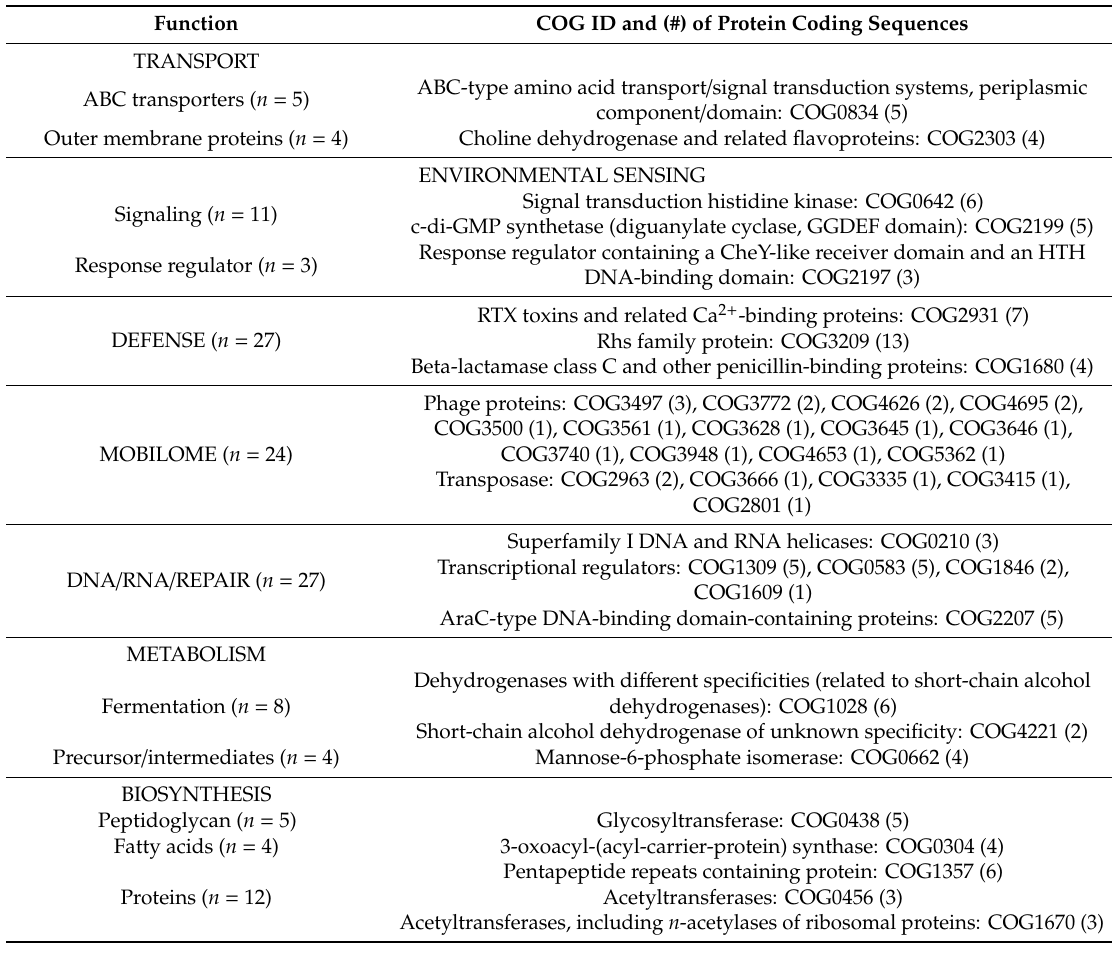
Table 2. Function and clusters of orthologous groups (COG) category for abundant putatively identified HGT events in Janthinobacterium sp. CG23_2. (For COG ID description see Table